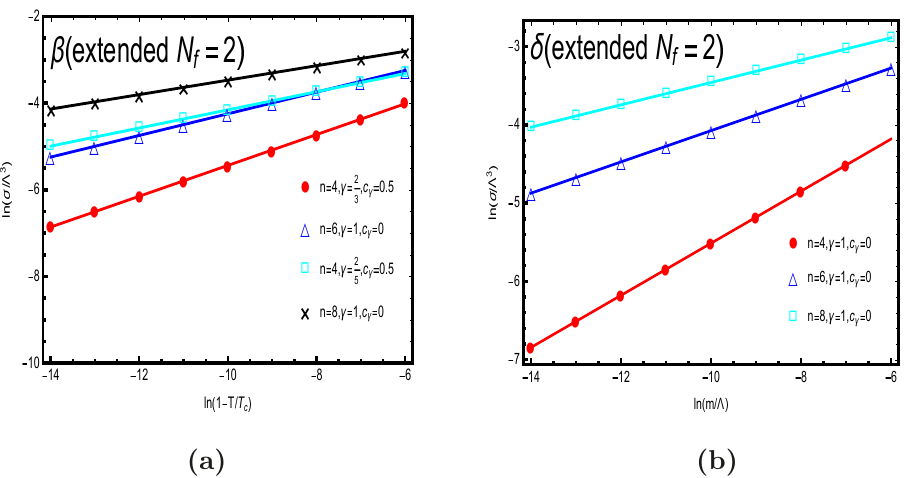
Figure 5 . Temperature and quark mass dependence of chiral condensate near the critical point T c, 2 = 0 . 1515 . . . MeV , m c, 2 = 0 , σ c, 2 = 0 with the extended dilaton profile in eq. (3.5) and higher T ) as a function of ln(1 ), with fixed quark mass power of scalar potential χ n . Panel.(a) gives ln( σ Λ T c − m = m c, 2 = 0. Λ = 1 GeV is a parameter introduced to make the quantity inside the logarithmic function dimensionless. The red circle, blue triangle, cyan rectangle and black cross dots are model calculation for n = 4 , γ = 2 , c γ = 0 . 5 , n = 6 , γ = 1 , c γ = 0 , n = 4 , γ = 2 , c γ = 0 . 5 , and 3 5 { } { } { } n = 8 , γ = 1 , c γ = 0 respectively. The solid straight lines are the corresponding linear fitting of { } the dots, which has the form y = 1 . 882 + 0 . 356 x , y = 1 . 749 + 0 . 250 x , y = 2 . 063 + 0 . 209 x and − − − y = 1 . 806 + 0 . 167 x respecitvely. Panel.(b) gives ln( σ ) as a function of ln( m ). The red circle, blue Λ Λ − triangle and cyan rectangle are model calculation for n = 4 , γ = 1 , c γ = 0 , n = 6 , γ = 1 , c γ = 0 { } { } and n = 8 , γ = 1 , c γ = 0 respectively. The solid straight lines are the corresponding linear fitting { } of the dots, which has the form y = 2 . 184+0 . 333 x , y = 2 . 075+0 . 200 x and y = 2 . 030+0 . 143 x − − −